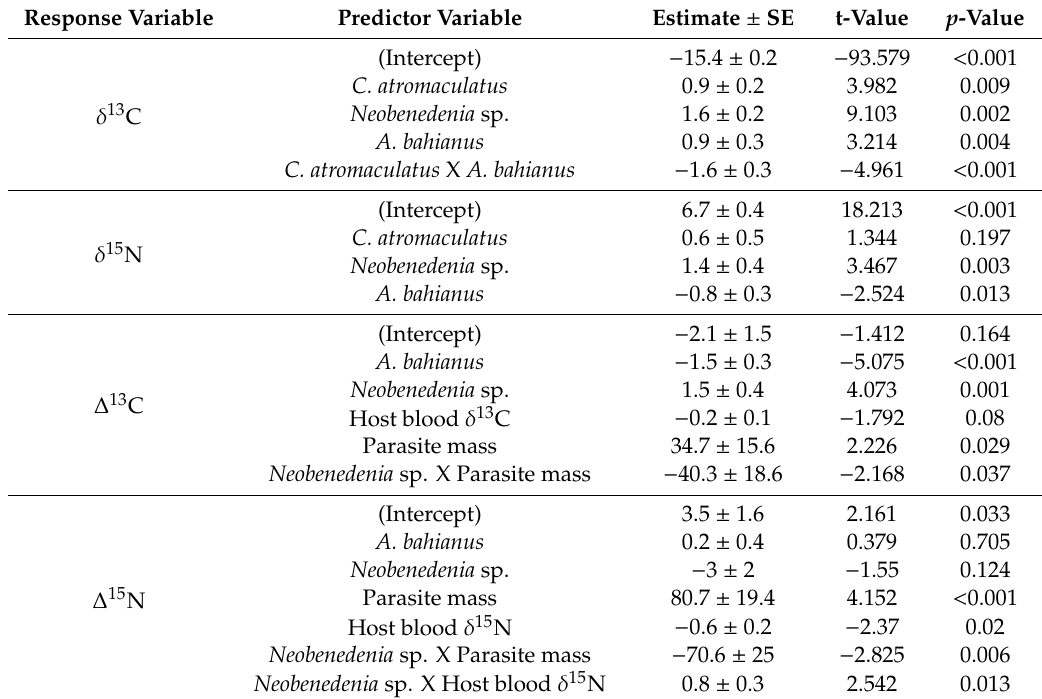
Table 3. Model estimated coe ffi